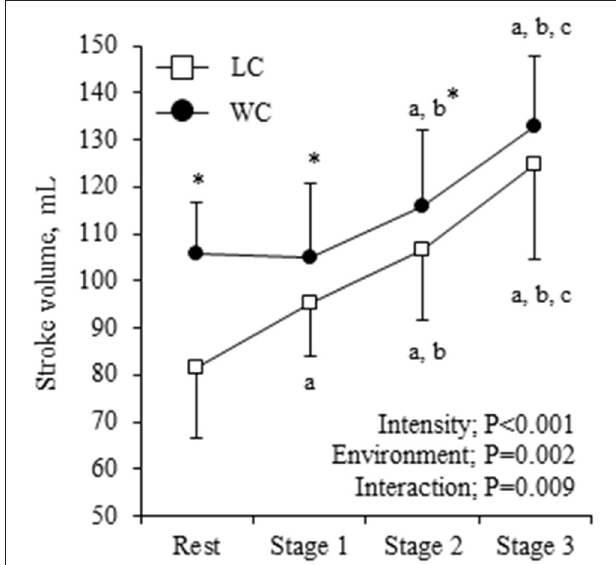
FIGURE 2 | Stroke volume (SV) response at rest and during exercise. Symbols and error bars are mean and SD. The circle and square indicate water-based and land-based exercise, respectively. The P -values for the two-way repeated ANOVA data are presented (environment, intensity, and interaction). a,b,c show significant differences from rest, stage 1, and stage 2 of the same environment, respectively. *indicates a significant difference from land at the same stage.